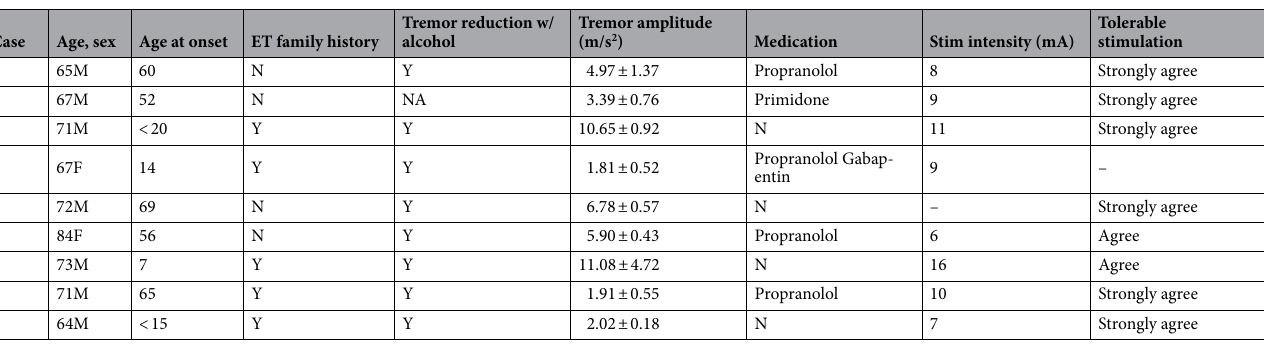
Table. 1. Clinical information and stimulation parameters of patients included in the study. Age and age at onset are in years. M = male; F = female; N = no; Y = yes; NA = not applicable as teetotal; – = missing observation. Tremor amplitude reflects the mean ± std tremor acceleration during the non-stimulation